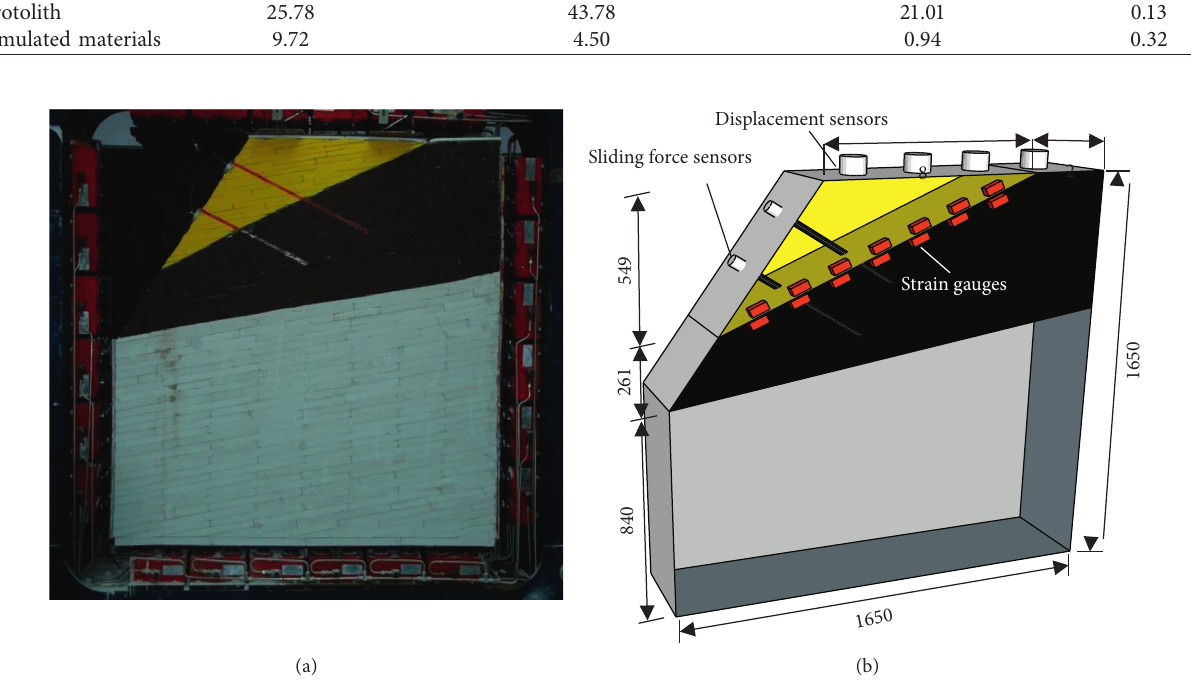
Figure 9: Image and schematic diagram of the physical